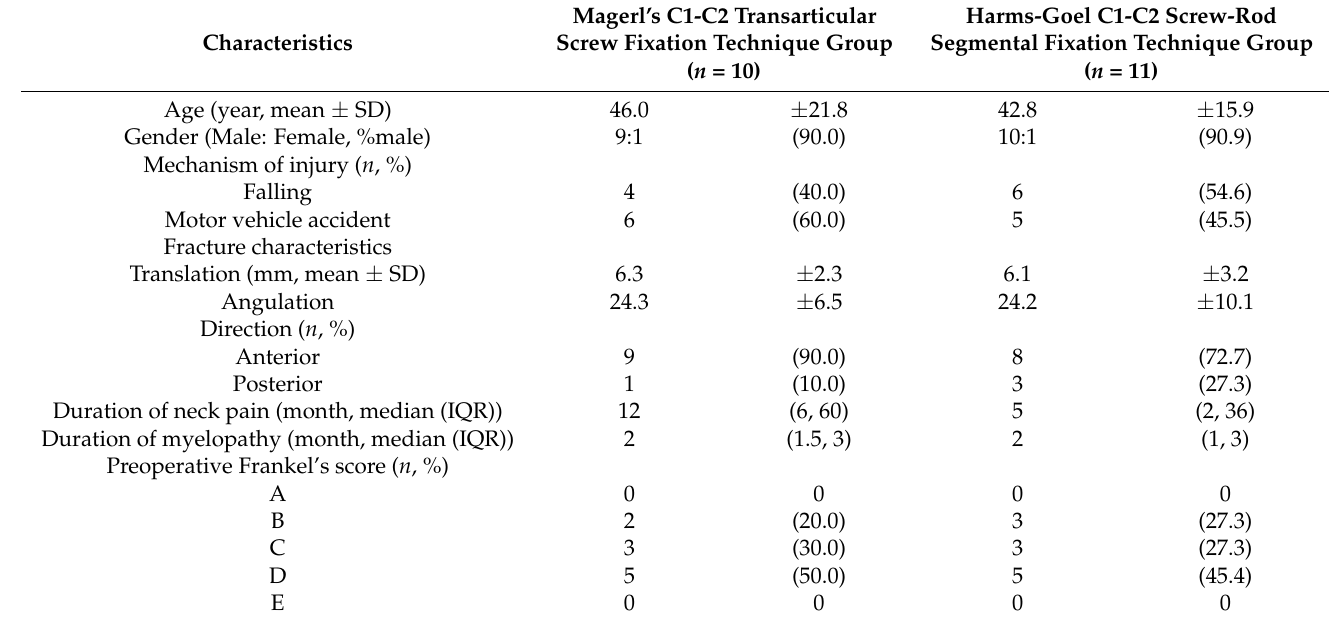
Table 1. Clinical and fracture characteristics of the